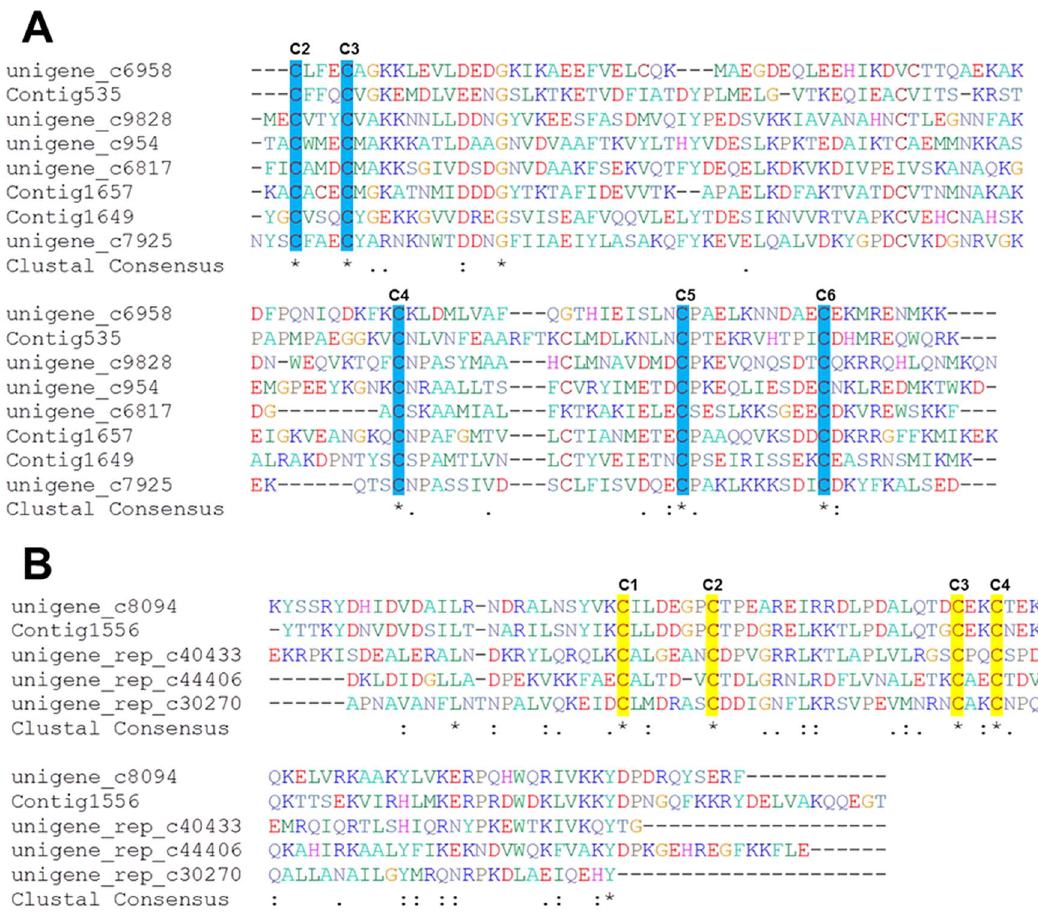
Figure 4. Multiple sequences alignment of deduced peptide sequences of the putative German cockroach OBPs (A) and CSPs (B) with those from other insect species. Nearly full-length amino acid sequences are aligned by ClustalX in BioEdit. Residues shaded in blue and yellow colors show the five and four conserved cysteine residues in the alignment of OBPs and CSPs, respectively. Asterisks (*) indicate identical sites in the sequence alignments; colons (:) represent sites with conserved substitutions, and black dots (